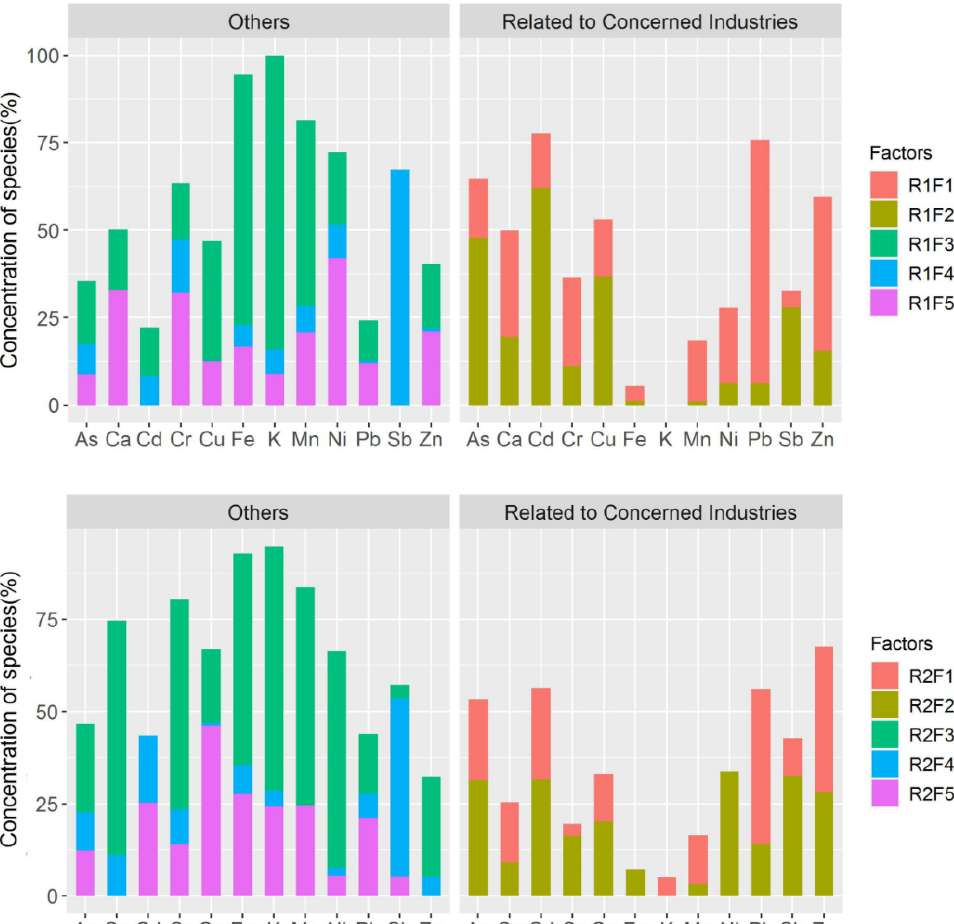
Figure 2. Contributions of the profiles for R1 ( top ) and R2 ( bottom ).